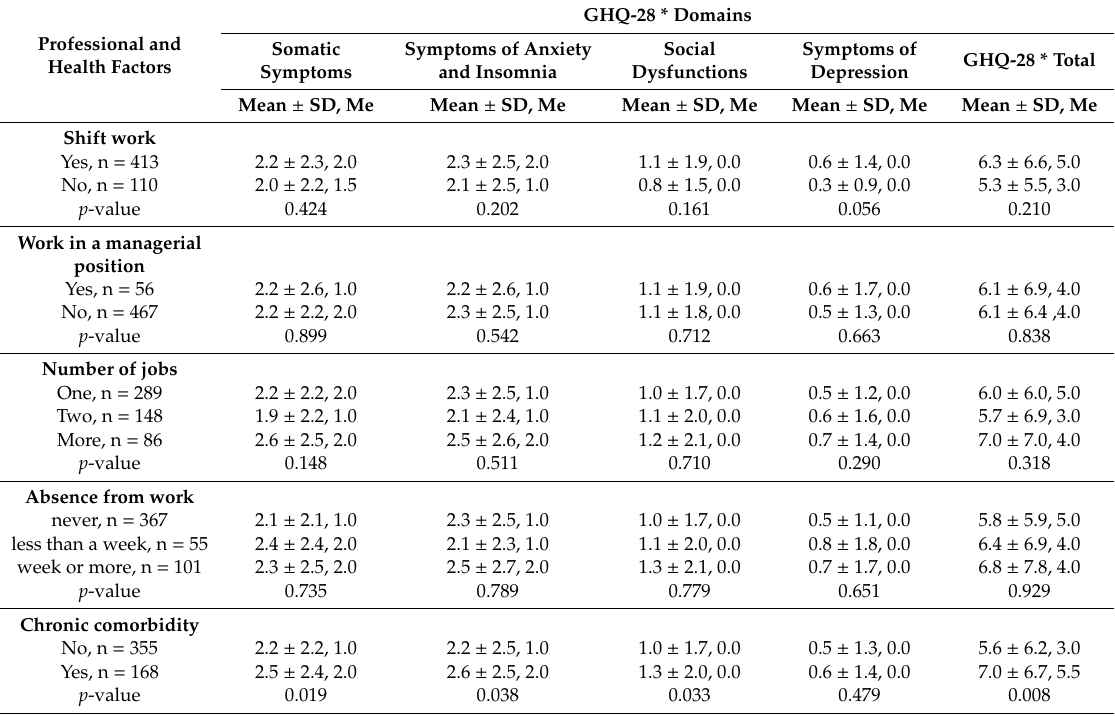
Table 2. Selected professional and health factors and respondents’ mental health